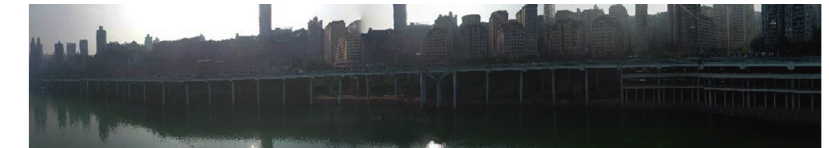
Figure 1: Riverside bridges located at Shabin Road, Chongqing,